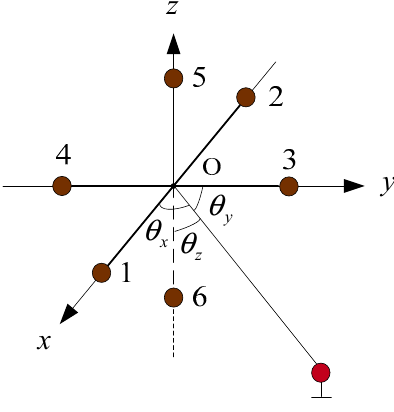
Figure 4. The schematic diagram of the USBL array structure based on six receiving array elements. The array elements 1, 2, 3, 4, 5, and 6 are all located on the coordinate axis. The